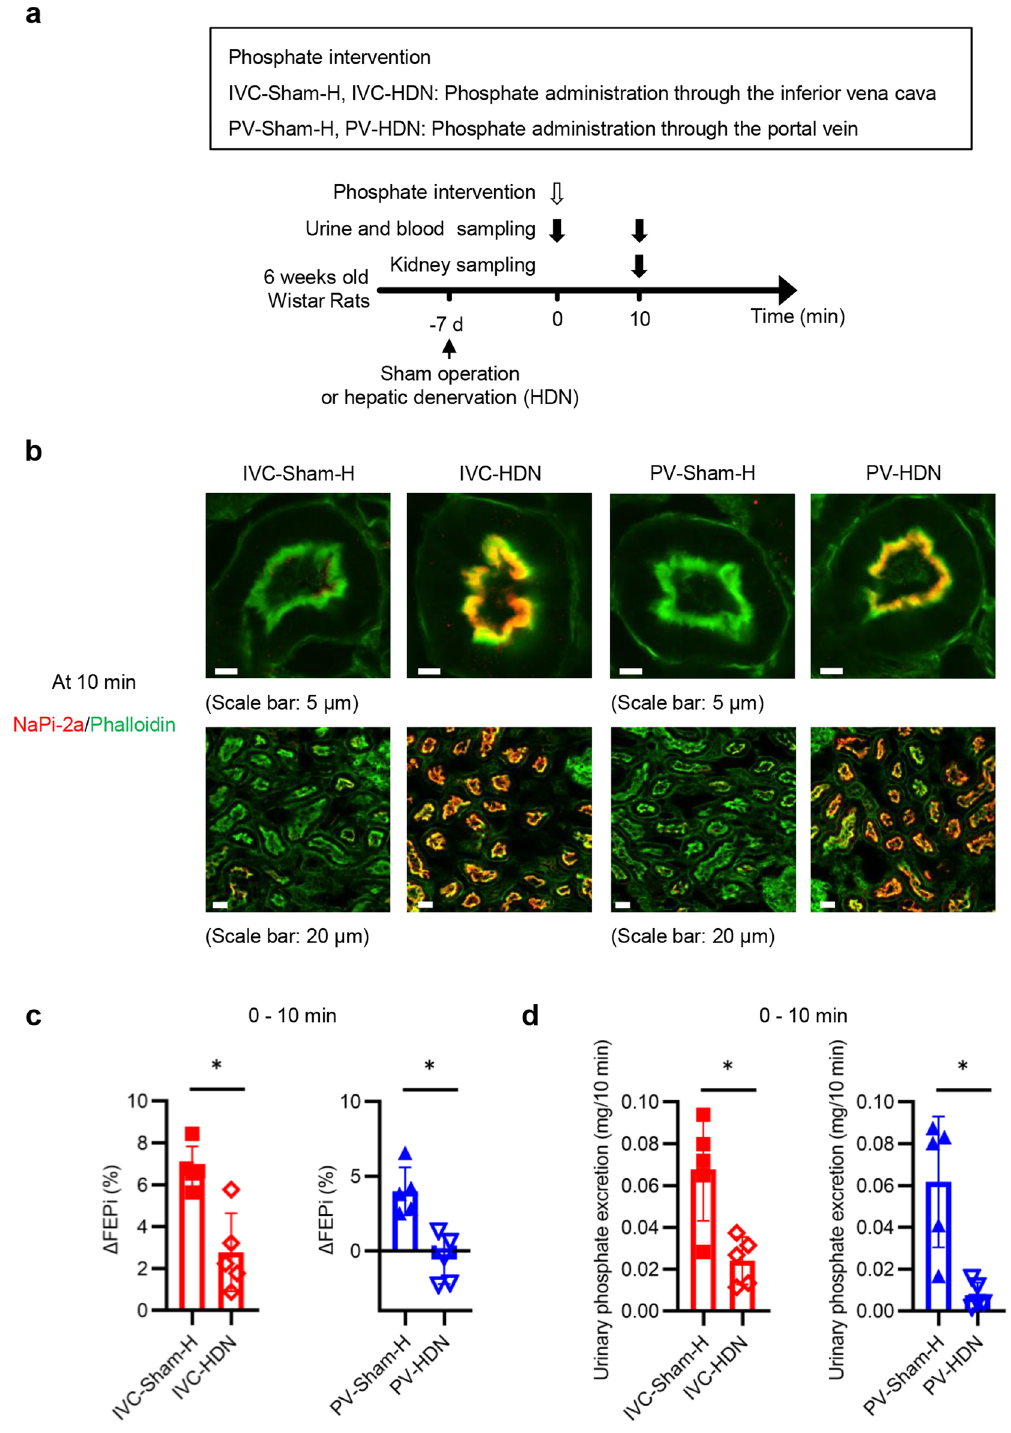
Figure 8. The hepatic nerves played critical roles in the elevation of FEPi between 0 and 10 min and urinary phosphate excretion during the 10-min period. ( a ) Experimental design for ( b ) to ( d ). Sham-operated rats and hepatic-denervated (HDN) rats were randomly divided into four groups, IVC-Sham-H, PV-Sham-H, IVC- HDN, and PV-HDN. Seven days after the operation, rats in the IVC-Sham-H and IVC-HDN groups, and rats in the PV-Sham-H and PV-HDN groups received phosphate interventions similar to those in the IVC and PV groups, respectively. ( b ) Representative immunofluorescence images of renal PTECs stained with phalloidin (green) and NaPi-2a (red) at 10 min. The upper and the lower images in each group are the immunofluorescence images with higher and lower magnification, respectively (scale bars: 5 µm or 20 µm). ( c ) ΔFEPi between 0 and 10 min (n = 5 rats per group). ( d ) Urinary phosphate excretion during the 10-min period (n = 5 rats per group). All results are presented as the means ± SDs, n.s.: not significant. * P < 0.05 based on the two-tailed Student’s t- test in ( c ) and ( d